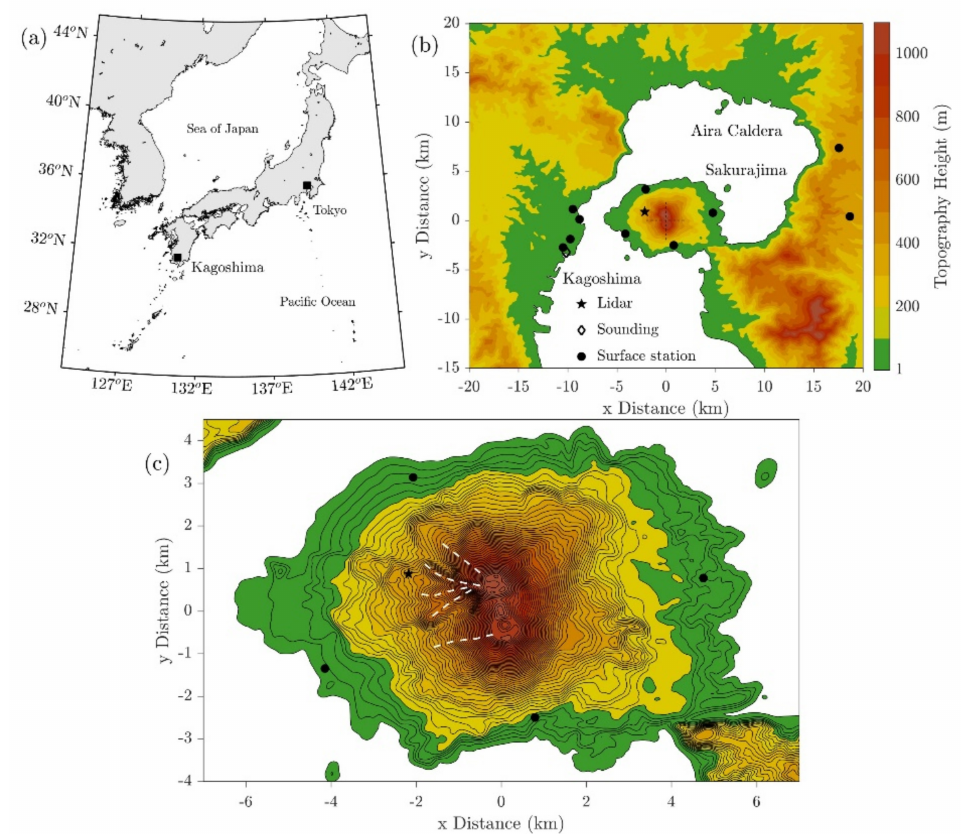
Figure 1. ( a ) Location of the study area (Kagoshima) in Japan. ( b ) Topographic map of the study area with the locations of Aira caldera, Sakurajima volcano, the city of Kagoshima, and observation points (shown as different markers). ( c ) Detailed topographic map over Sakurajima volcano. Topographic contours are shown shaded every 100 m, and with black contour lines every 20 m (Panel c ). Ridges in the lee side of the volcano are shown with dashed lines.